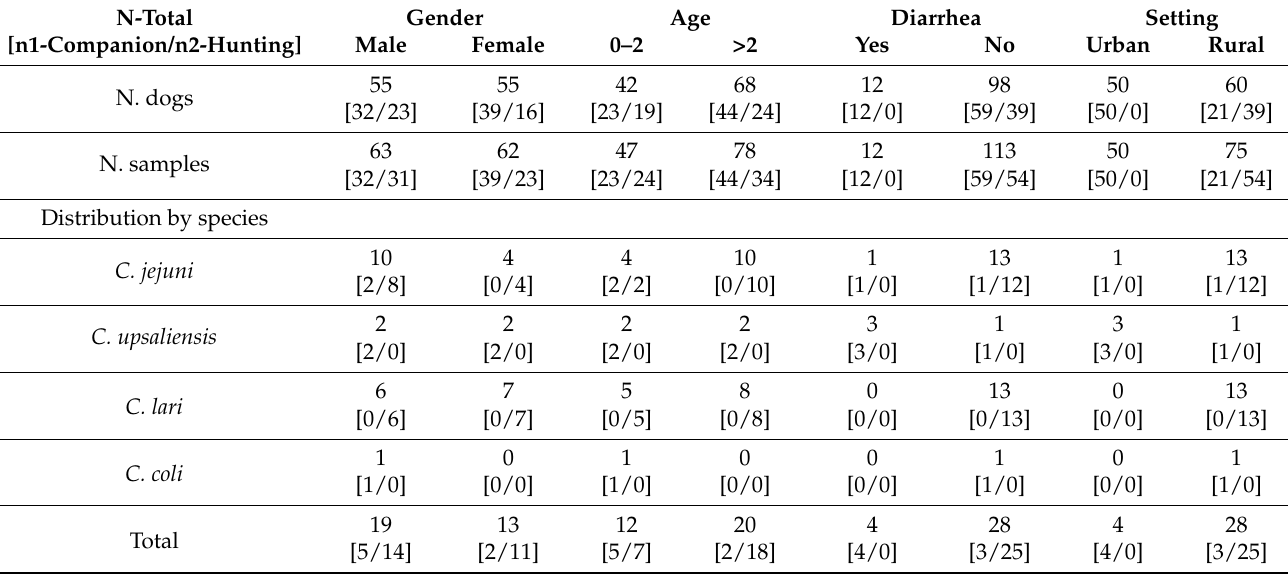
Table 1. Characteristics of the samples collected ( n = 125) and species distribution among Campylobacter isolates ( n = 32), according to canine